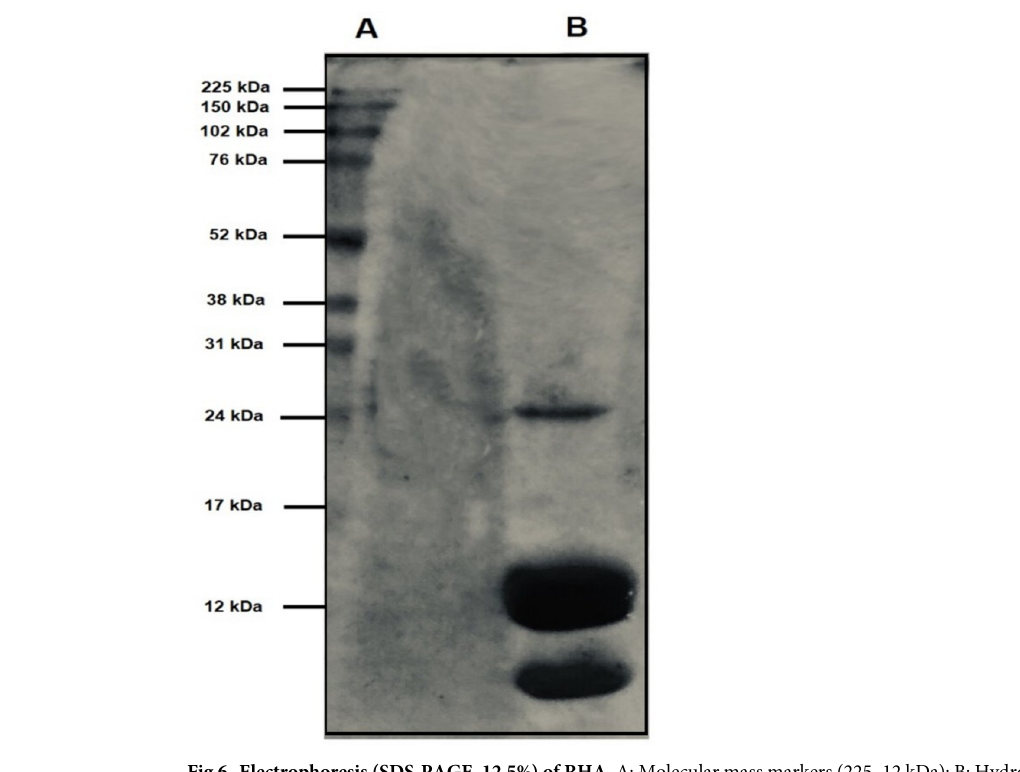
Fig 6. Electrophoresis (SDS-PAGE, 12.5%) of RHA. A: Molecular mass markers (225–12 kDa); B: Hydroethanolic extract from roots, RHA (30 μ g).